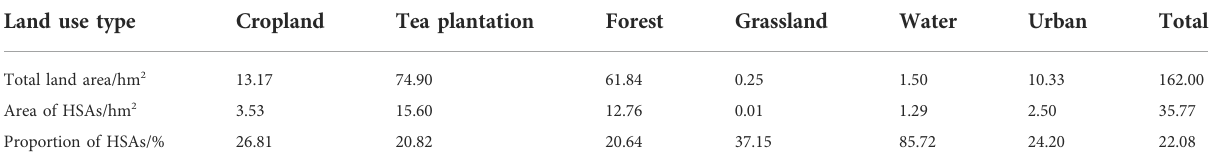
TABLE 2 Distribution of different land use types in hydrological sensitive